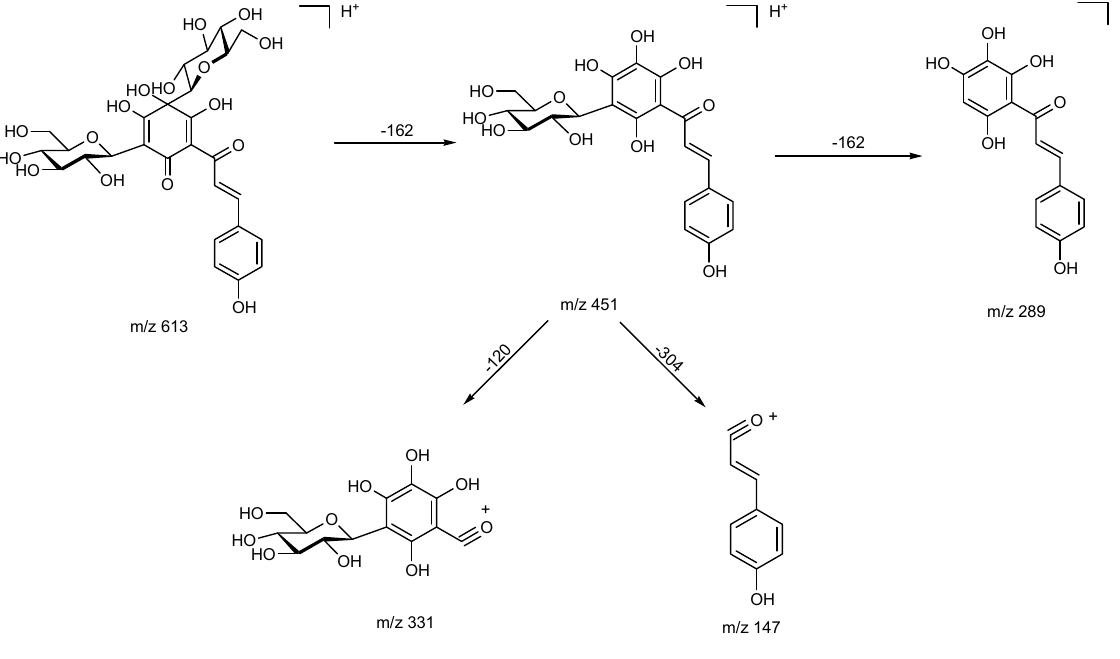
Table 9. The common fragmentations of quinochalcone C -glycosides in negative ion mode. Fragmentation Pathway ( m/z ) Attribution of Fragment Ions HSYA SYA